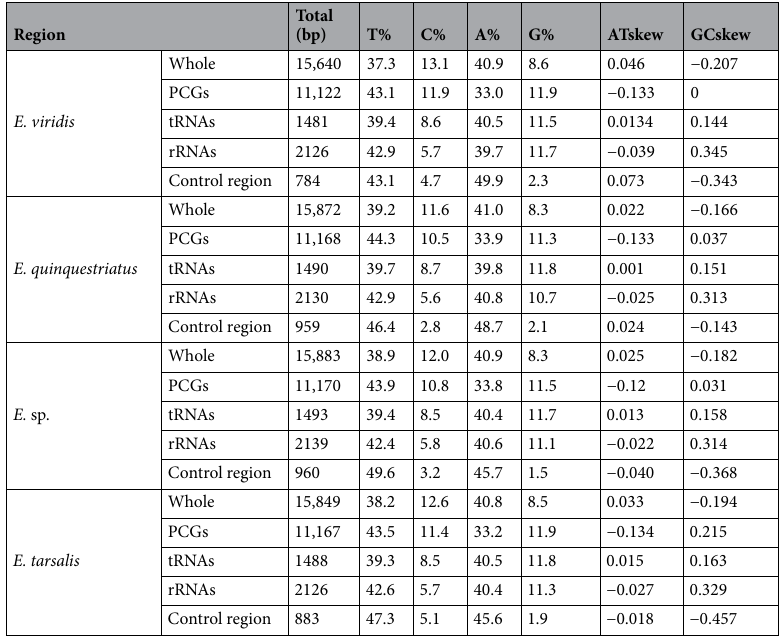
Table 2. Nucleotide composition of the four sequenced species complete mitogenomes of Eristalinus